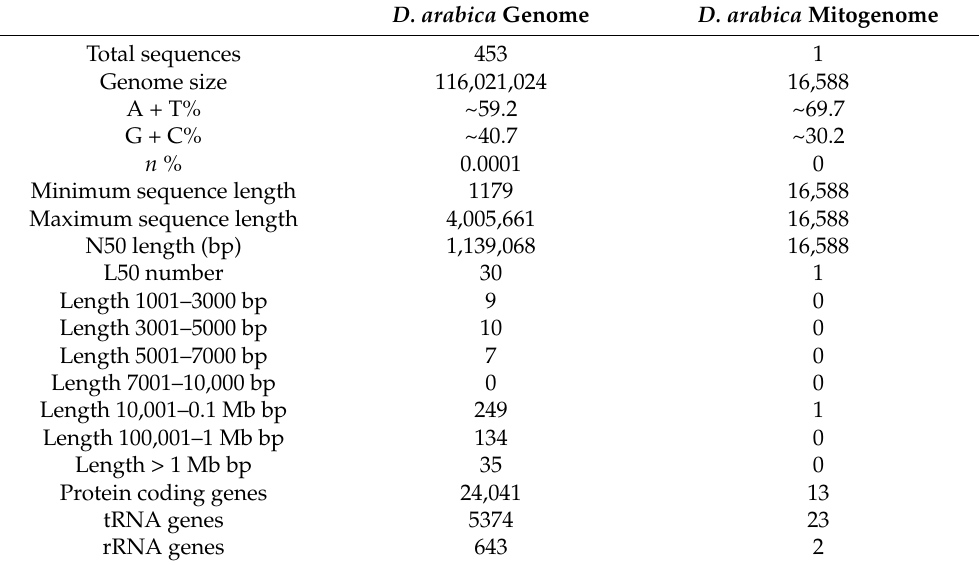
Table 1. D. arabica whole genome assembly